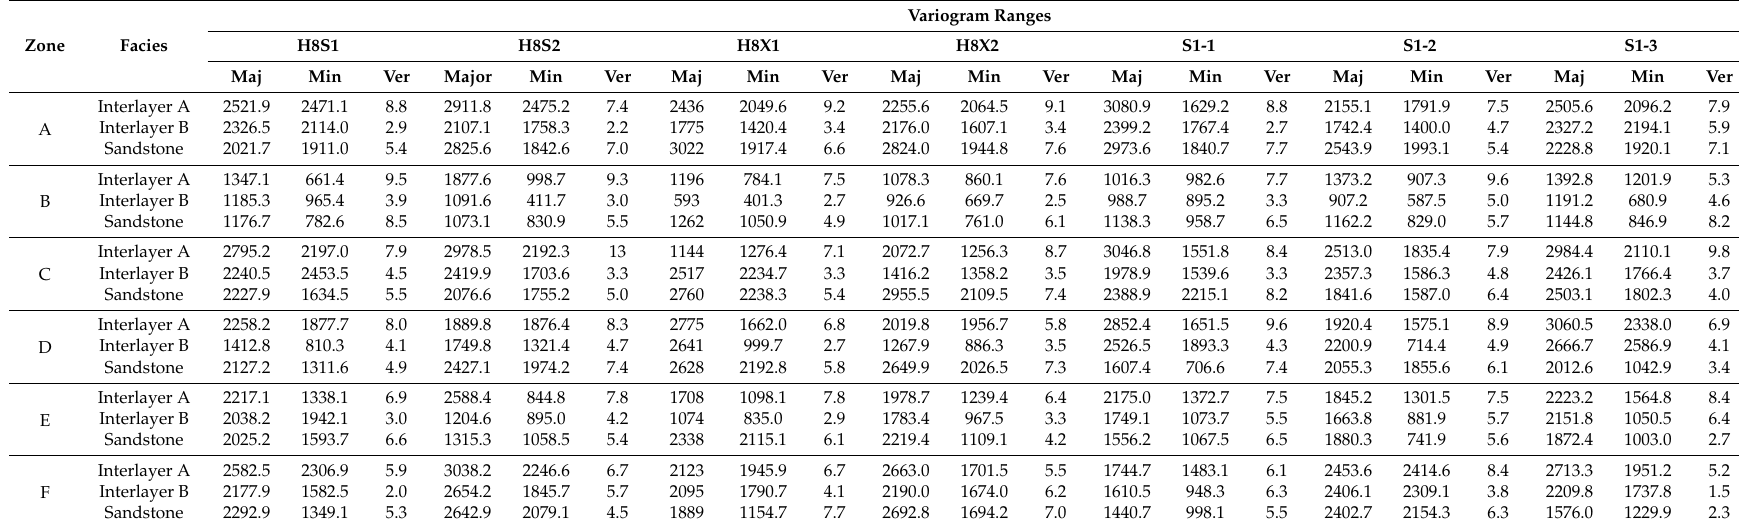
Table 3. Varaiogram parameters for the six subdivided